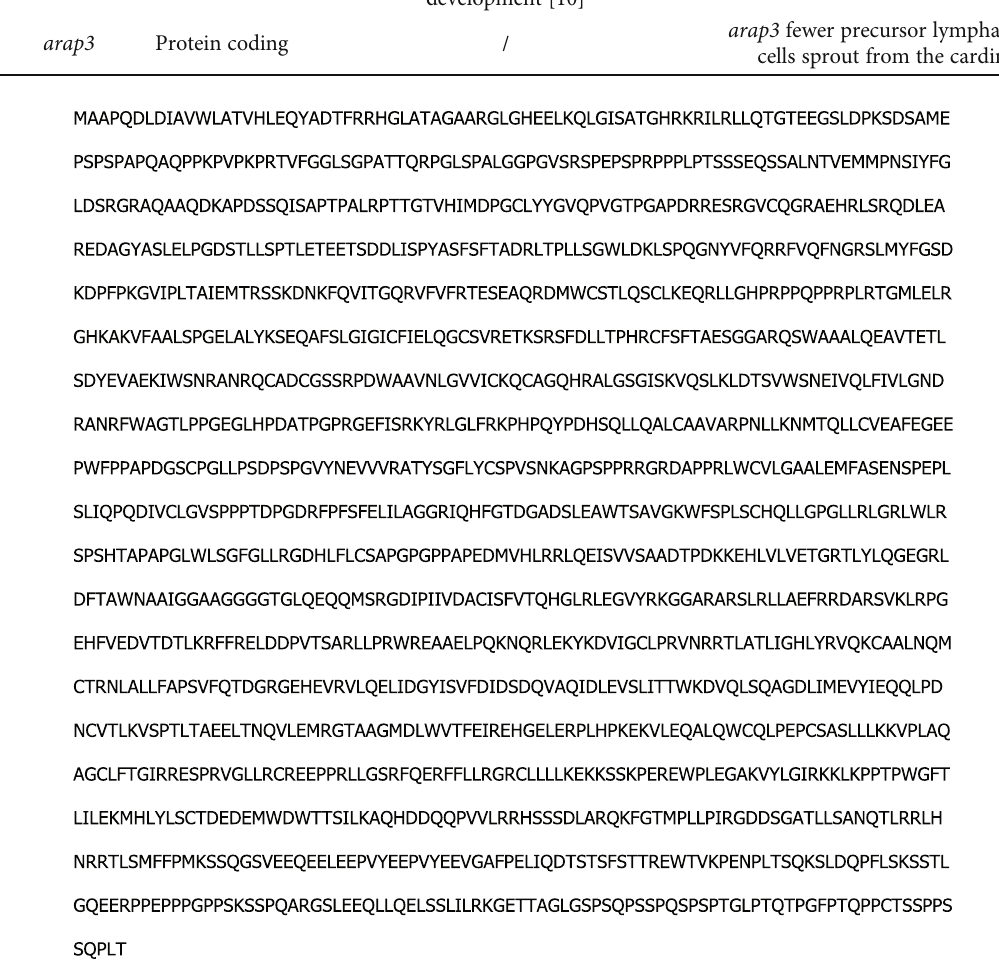
Figure 1: Primary amino acid sequence used to search for templates and build models.